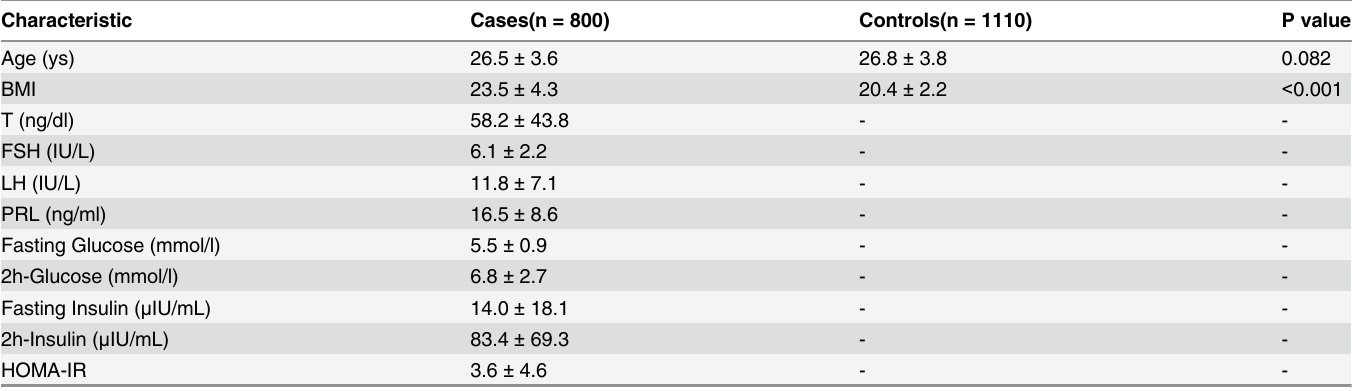
Table 1. Characteristics of the case and the control subjects.